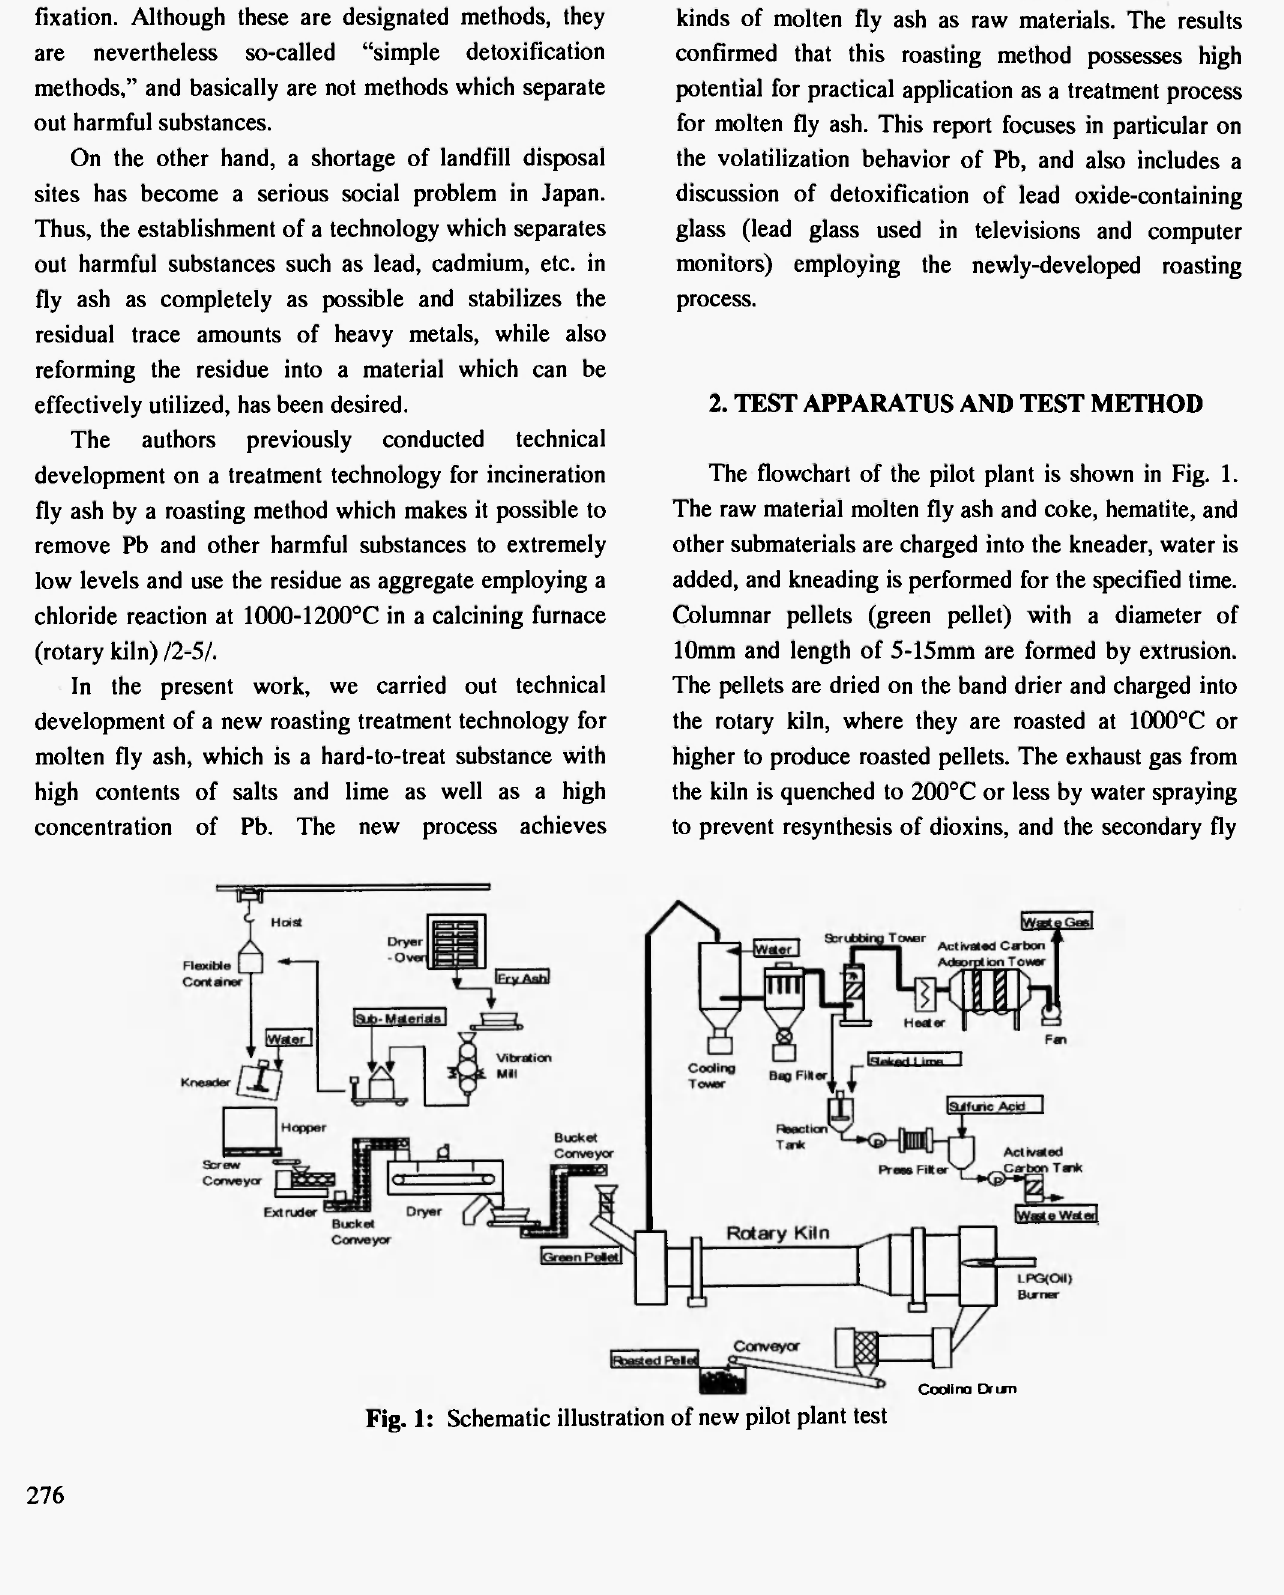
Fig. 1: Schematic illustration of new pilot plant